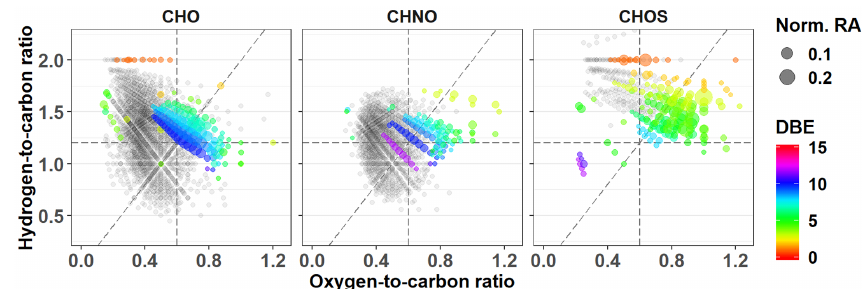
Figure 8. PMO-2 van Krevelen plots for unique molecular formulas separated by group. Symbols are scaled to indicate the normalized relative abundance (Norm. RA). The DBE is indicated for each group of unique molecular formulas using colored symbols. Formulas common with other samples are provided in gray for